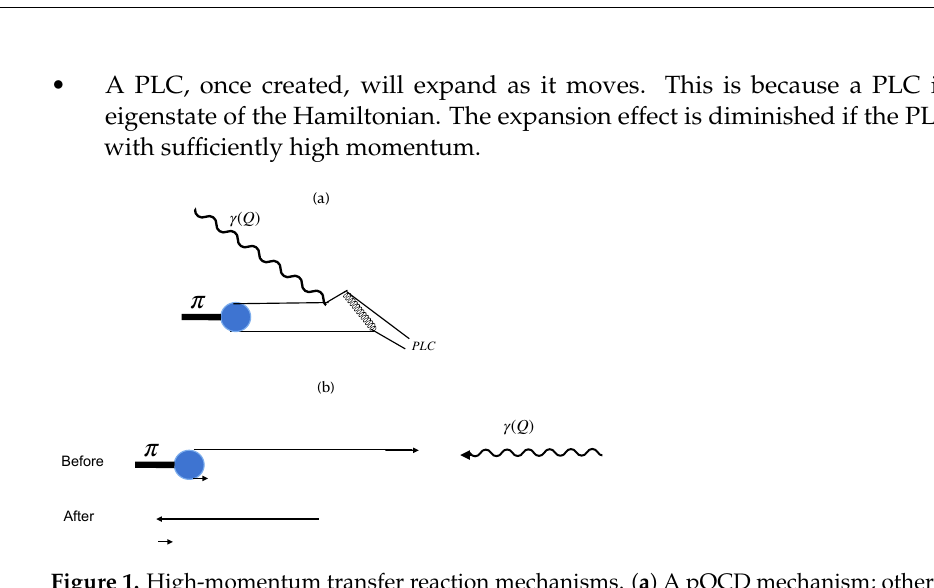
Figure 1. High-momentum transfer reaction mechanisms. ( a ) A pQCD mechanism; other diagrams of the same order are not shown. ( b ) Initial state (top) and final state (bottom) in the Feynman mechanism. The final state overlaps well with the turned around version of the initial state. See text for